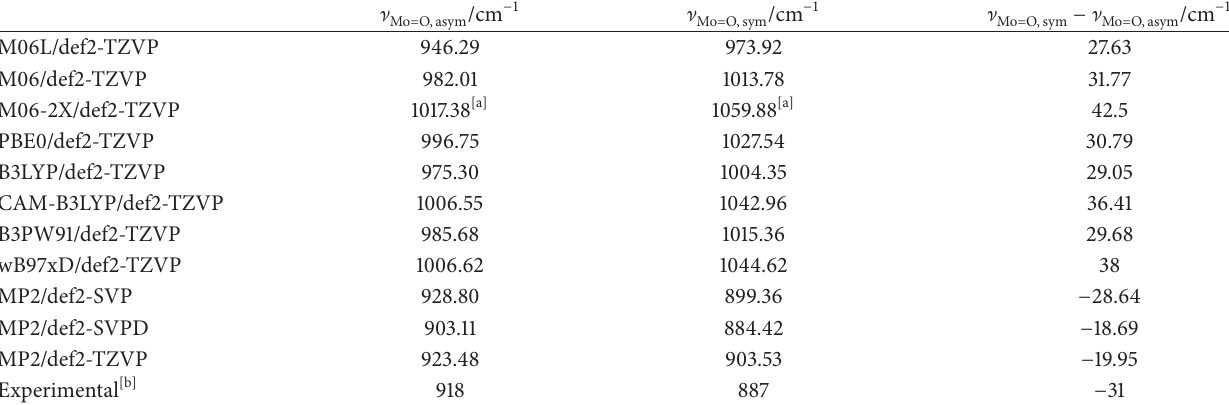
Table 7: Mo=O stretching and Cp’s C–H OOP bending frequencies for 2 .